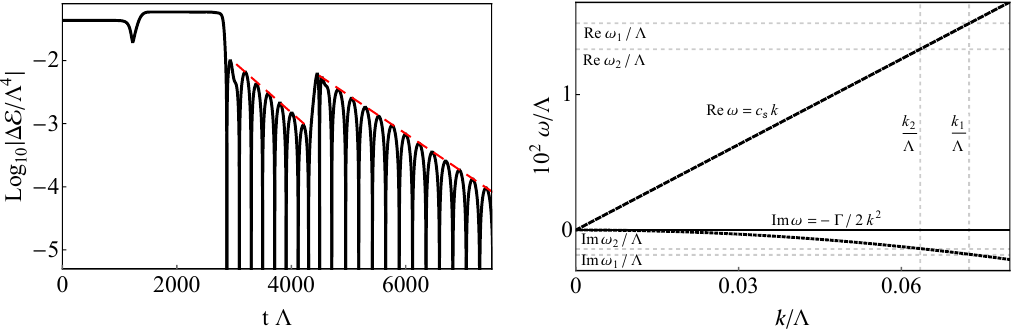
Figure 24 . (Left) The black curve shows the di(cid:11)erence (cid:1) E = E (cid:0) E high on a slice at constant z (cid:3) = 46 in (cid:12)gure 4, which corresponds to the center of the (cid:12)nal domain. The slopes of the (cid:12)tted straight lines (in dashed red) determine Im ! 1 and Im ! 2 , whereas the separation between maxima determine Re ! 1 and Re ! 2 . (Right) The two independent values of k obtained from comparing